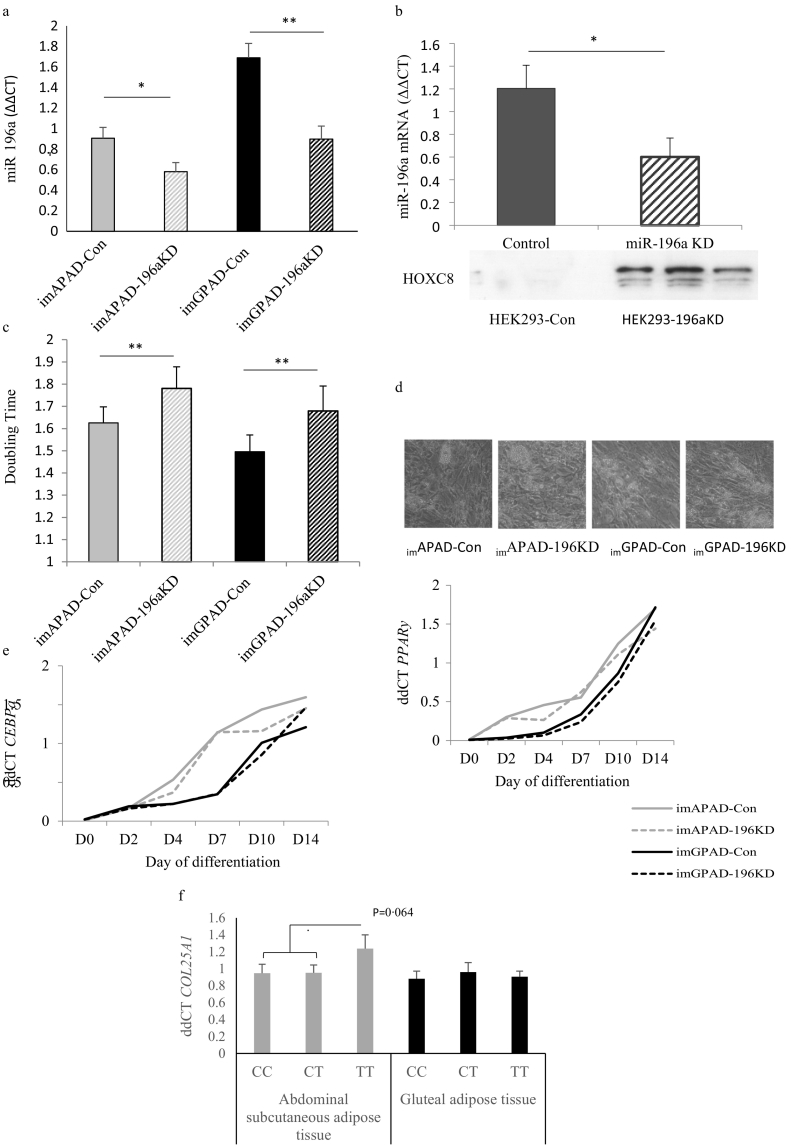
a. Expression of miR-196a in imGPAD and imAPAD cell lines following transduction of miR-196aKD or control vector (*p < 0∙05 **p < 0∙005; paired t-test).b. miR-196a and HOXC8 protein in HEK293 cell lines following transduction of miR-196aKD or control vector (*p < 0∙05; paired t-test).c. Preadipocyte doubling time of the imGPAD and imAPAD cell lines following transduction of miR-196aKD or control vector, **p < 0∙005.d. Light microscopy (x10 magnification) of the imGPAD and imAPAD cell lines following transduction of miR-196aKD or control vector after 14 days of in vitro differentiation.e. mRNA expression of PPARγ2 and CEBPα throughout the 14-day differentiation time-course.f. COL25A1 expression in paired ASAT and GSAT biopsies from age, sex and genotype-balanced group of rs11614913 (n = 30 in each group).